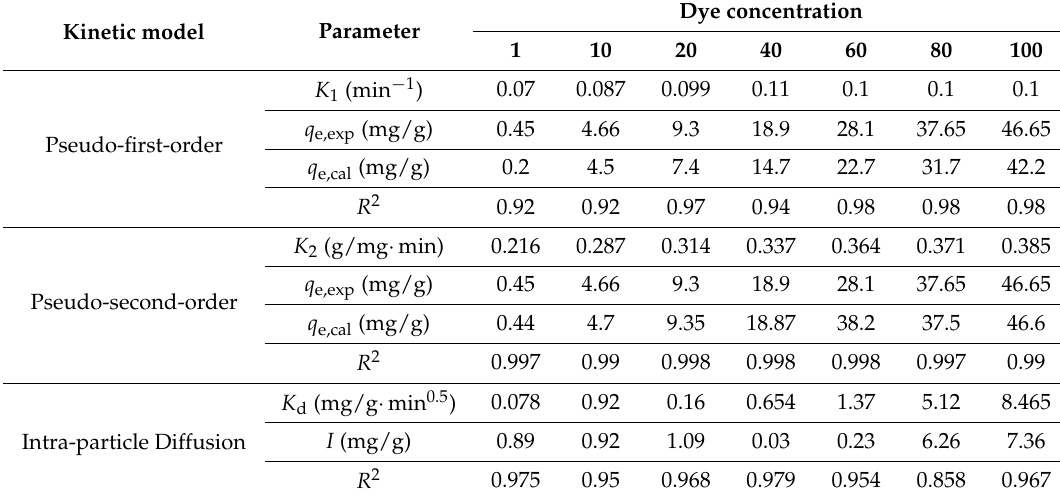
Table 2. Estimated kinetic parameters for the different kinetic models of the dye adsorption process onto the chemically modified nanofibers.